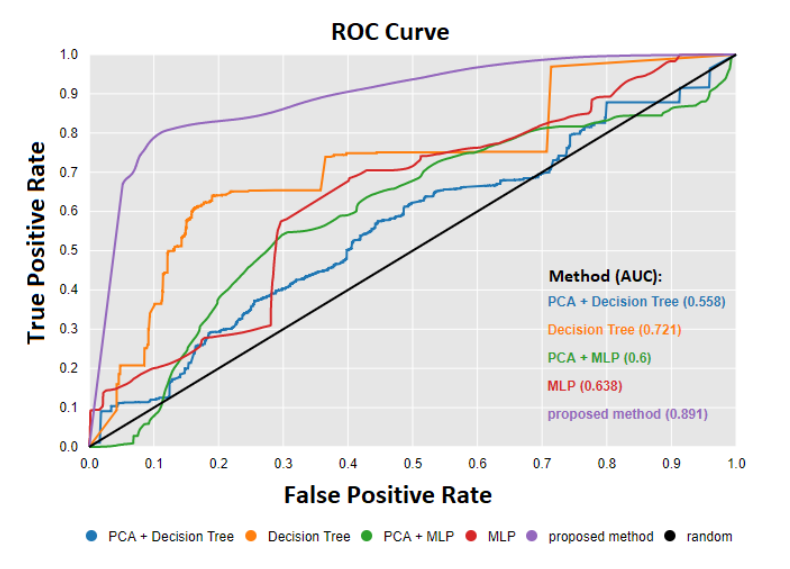
Figure 11. Receiver operating